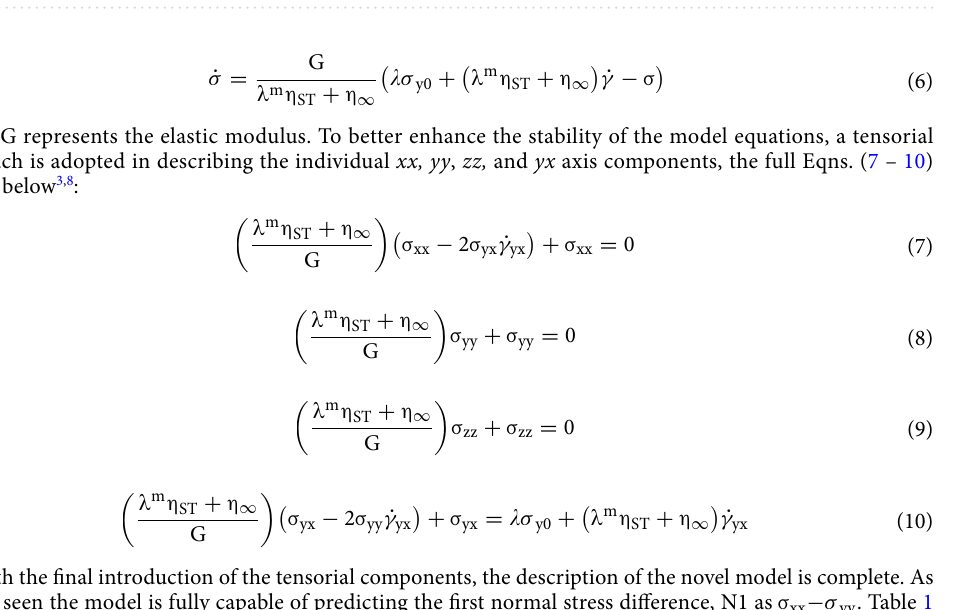
Table 1. t-e-Thixo-Visco-Plastic Viscoelastic